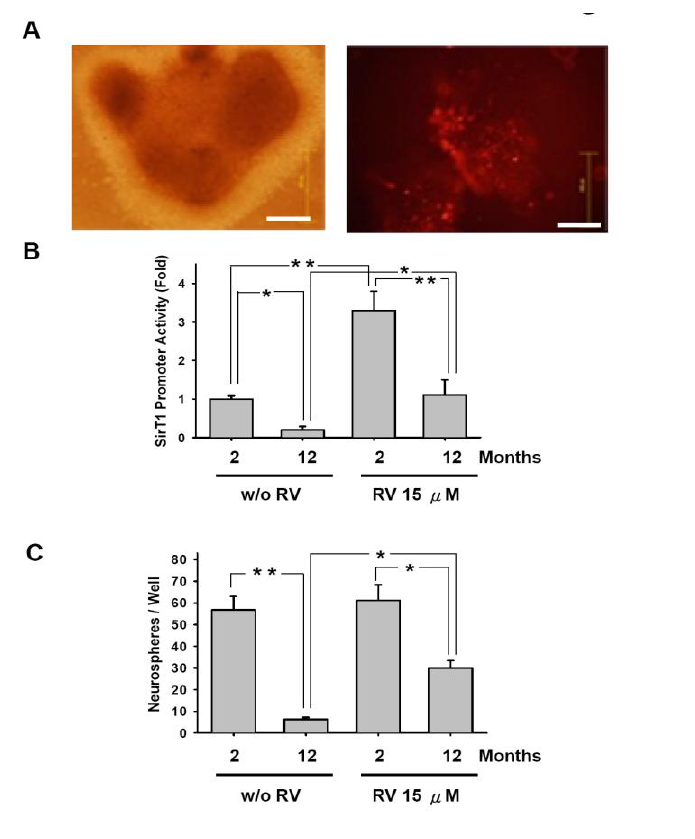
Figure 7. Resveratrol promoted SirT1 activities and enhanced the self-renewal abilities to increase from 2- and 12-month-old rats were transfected with pDsRed-SirT1p. After 7 days of serum-free culture, RFP-positive cells were detected in spheres. (Bar: 40 μm) (B & C) RSCs isolated from 2- and 12-month-old rats were transfected with pGL2-SirT1p. After 7 days of serum-free culture with or without RV, cell lysates were assayed for luciferase activity (B) relative to 2-month-old rat RSC without RV treatment) and the number of neurospheres was counted; (C). *p < 0.05; **p < 0.01. Data shown here are the means ±SD of three independent